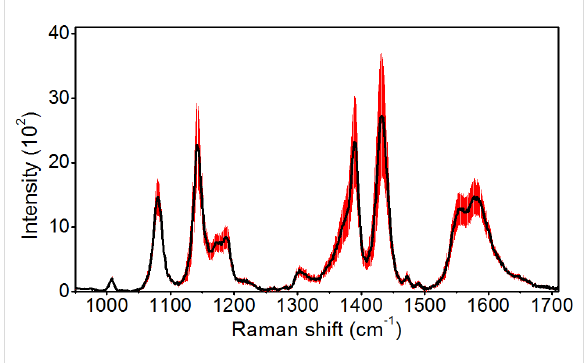
Figure 6: SERS spectrum recorded for sample B (black line – the av- erage SERS spectrum; red area – the standard deviation of the signal.